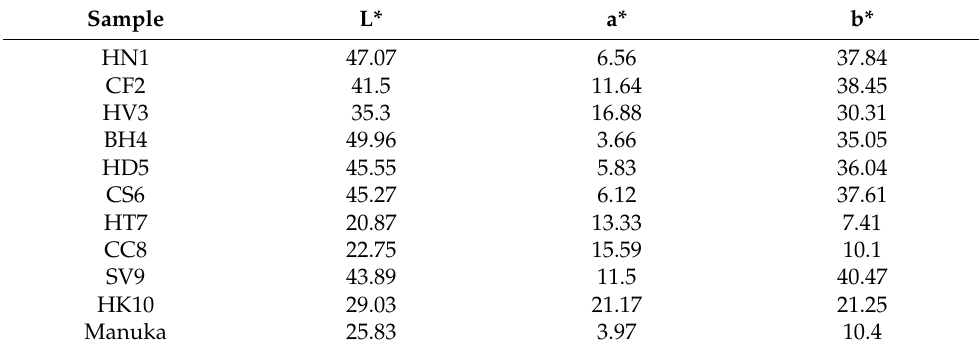
Table 5. Colour parameters of different types of